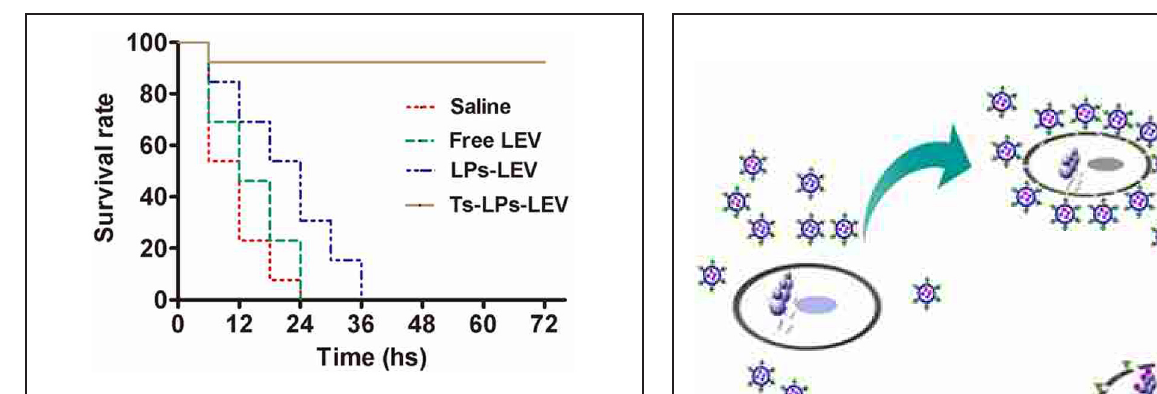
FIGURE 8 | Mortality data reported as Kaplan–Meier curves for levofloxacin formulations in a septic shock model induced by a multidrug resistant (MDR) clinical isolate. After bacterial challenge by injection of 2.5x10 7 CFU of the multidrug-resistant clinical isolate K. pneumoniae CI 130702215, the animals were immediately injected in their tail veins with sterile saline, free levofloxacin, LPs-LEV or Ts-LPs-LEV. The survival rate was monitored every 6 h for 3 days without any intervention except for the experimental drugs. TABLE 4 | Bacterial clearance and mouse survival in septic shock models. Treatment